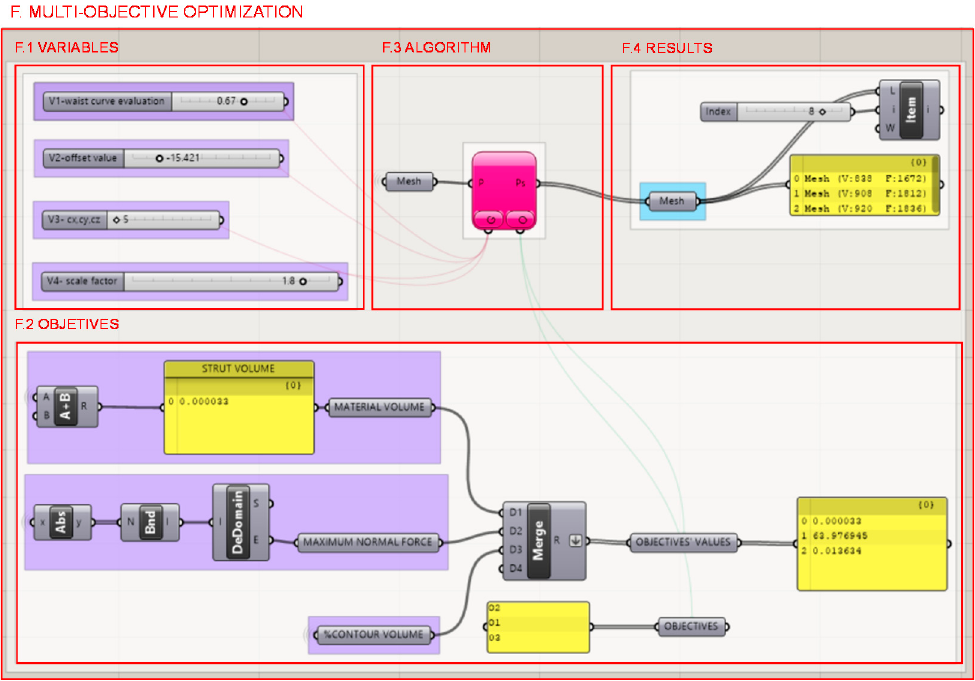
Figure 35. Programming structure definition to define the multi-objective optimization problem to be solved with the Octopus plug-in algorithm.